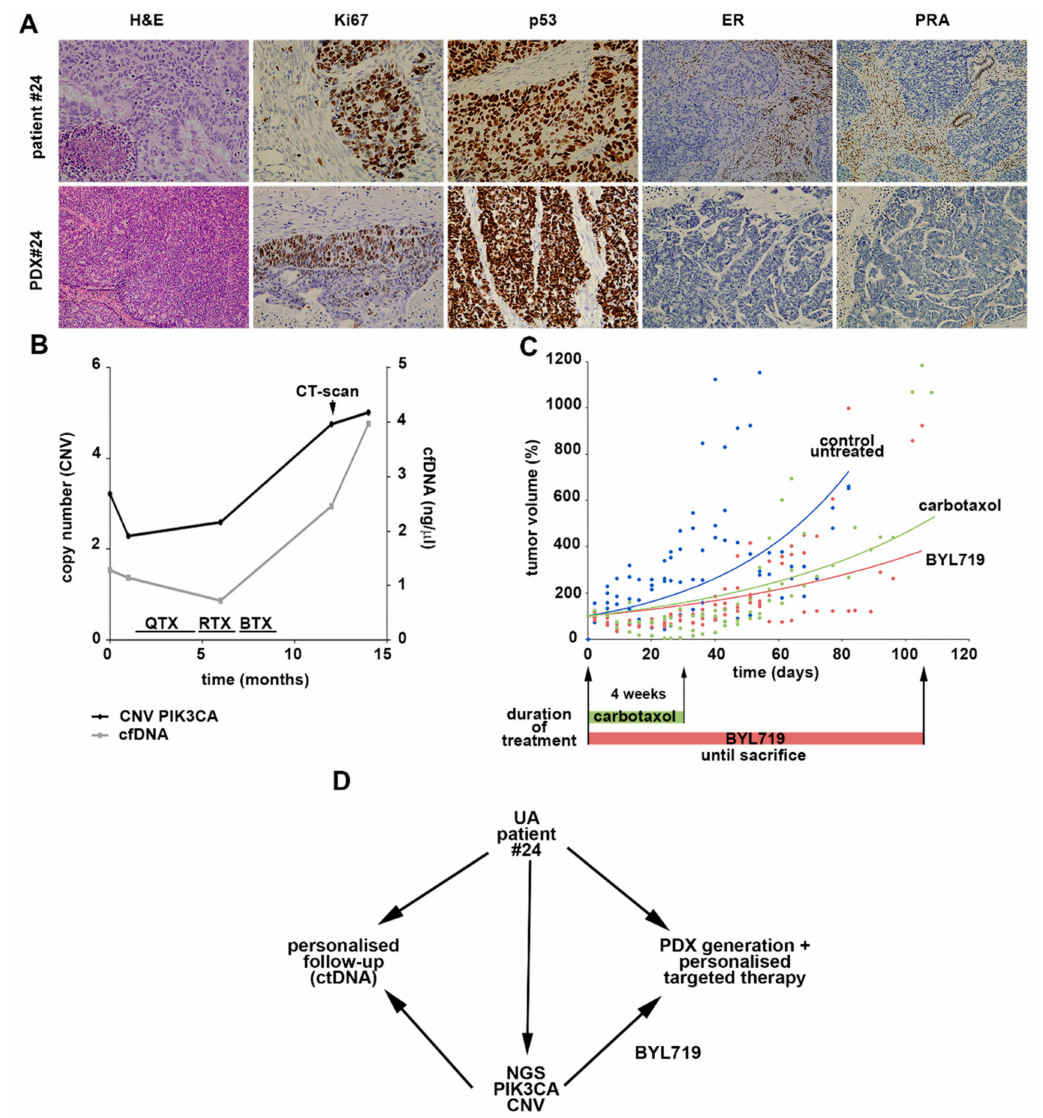
Figure 5. Patient-derived xenograft (PDX) generation from uterine aspirate (UA) of Patient #24 as a preclinical model to test targeted therapies. ( A ) Comparison of histology and immunohistochemistry between the patient primary tumor and the PDX generated from the UA collected at surgery. ( B ) cfDNA and ctDNA level dynamics during disease evolution. QTX: chemotherapy; RTX: radiotherapy; BTX: brachytherapy. ( C ) PDX tumor growth evolution in response to carboplatin / paclitaxel (weekly intraperitoneal injection for 4 weeks, n = 3), BYL719 (daily oral gavage; n = 4), or control (methyl cellulose daily oral gavage; n = 4) treatment. ( D ) Summary of the combined liquid biopsy strategy to achieve personalized treatment for the patients with EC included in our